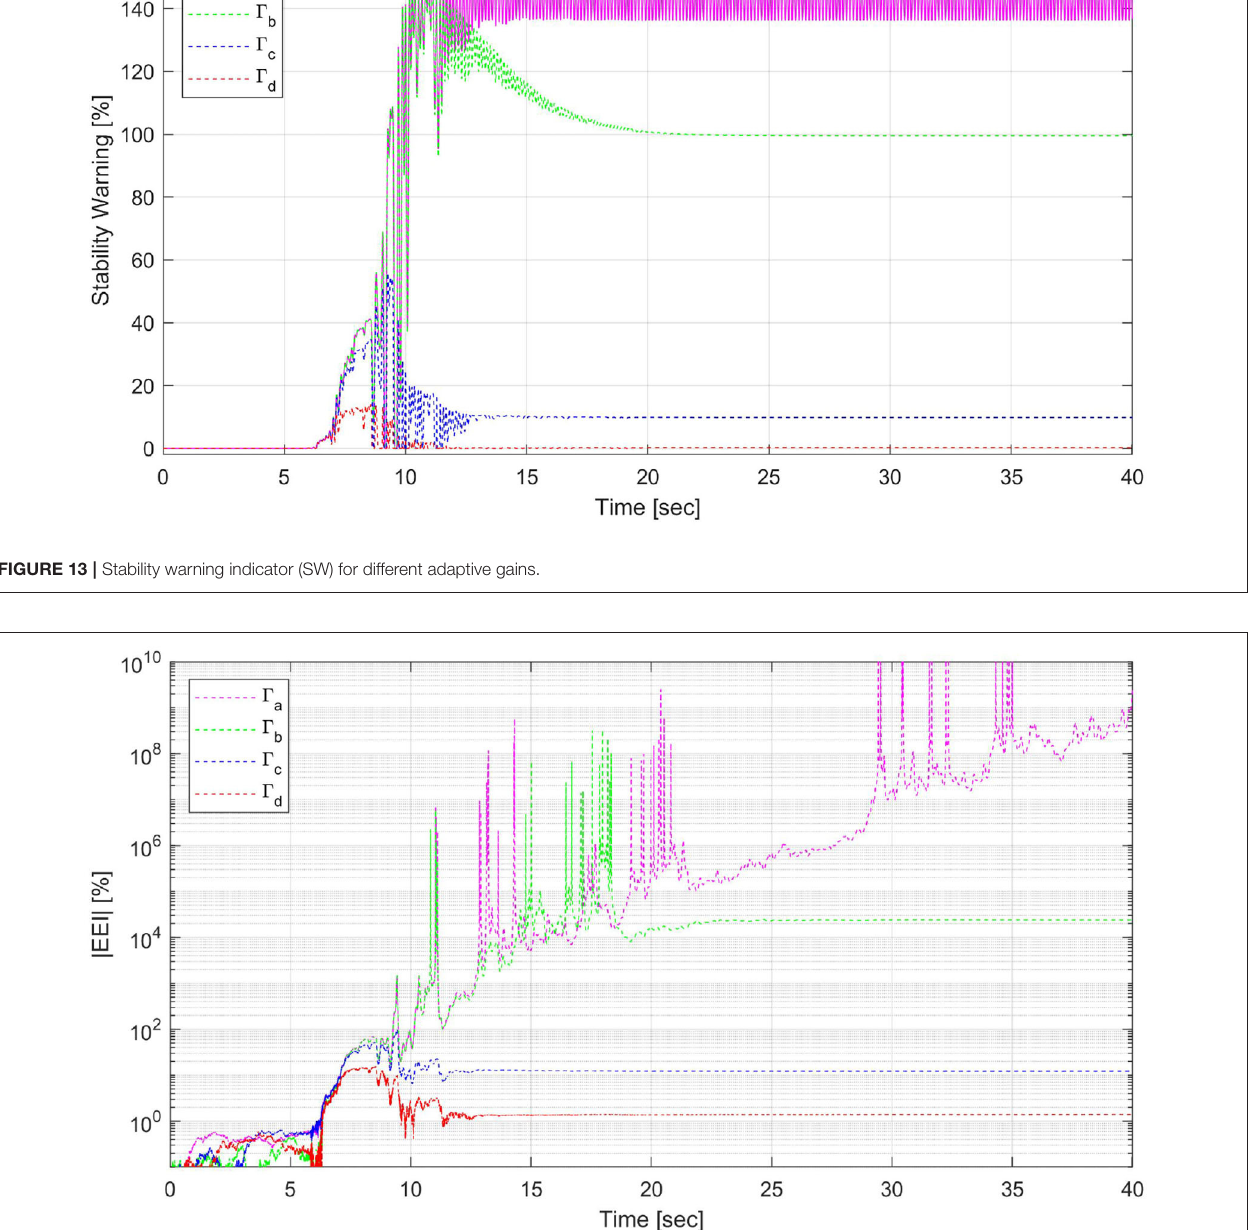
FIGURE 14 | Energy error indicator (EEI) for different adaptive